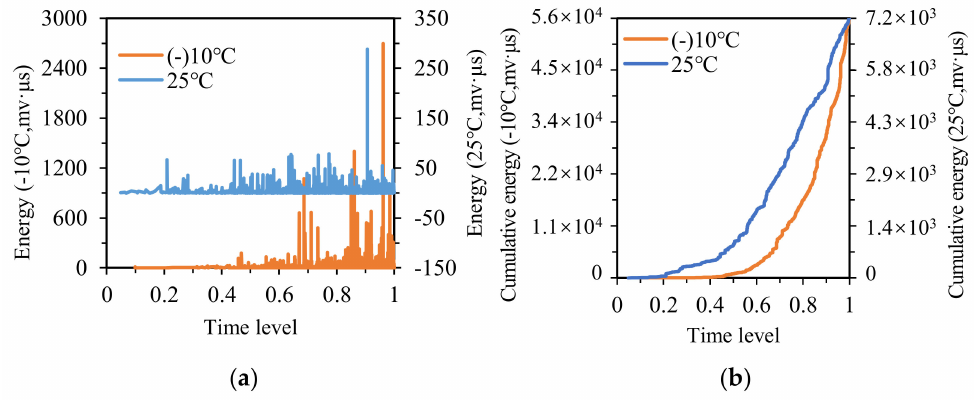
Figure 10. The energy and cumulative energy distribution of AC at − 10 ◦ C and 25 ◦ C: ( a ) energy; ( b ) cumulative energy.